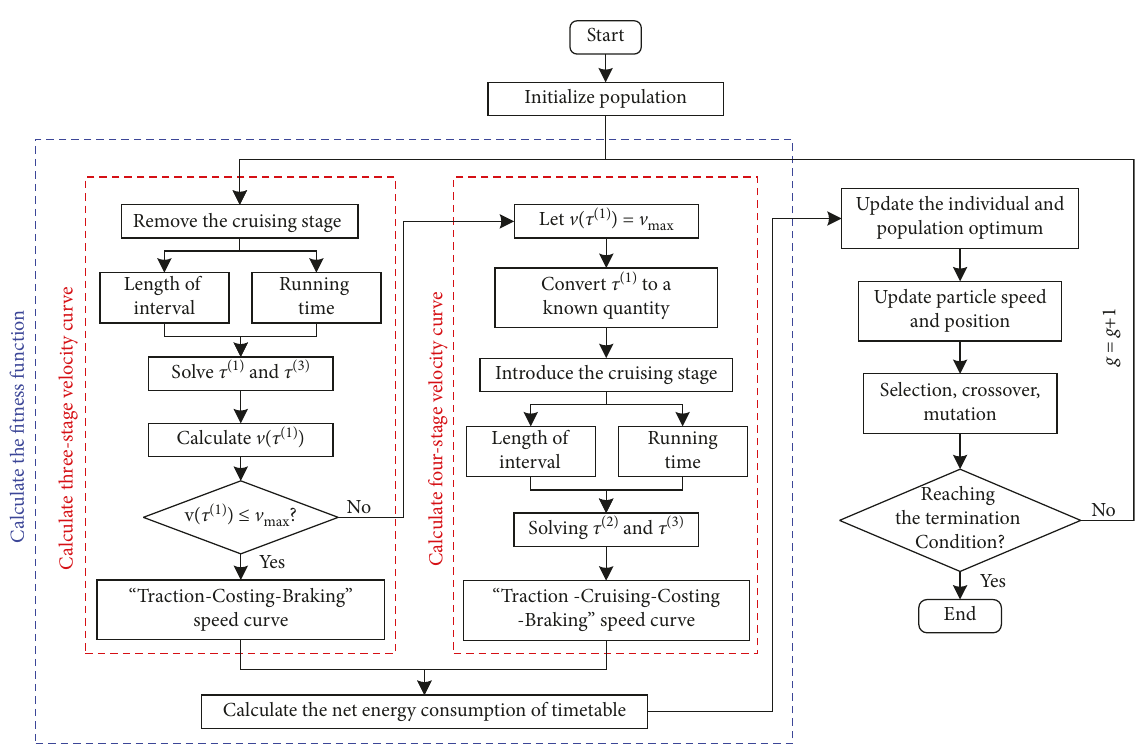
Figure 4: Flowchart of the solution